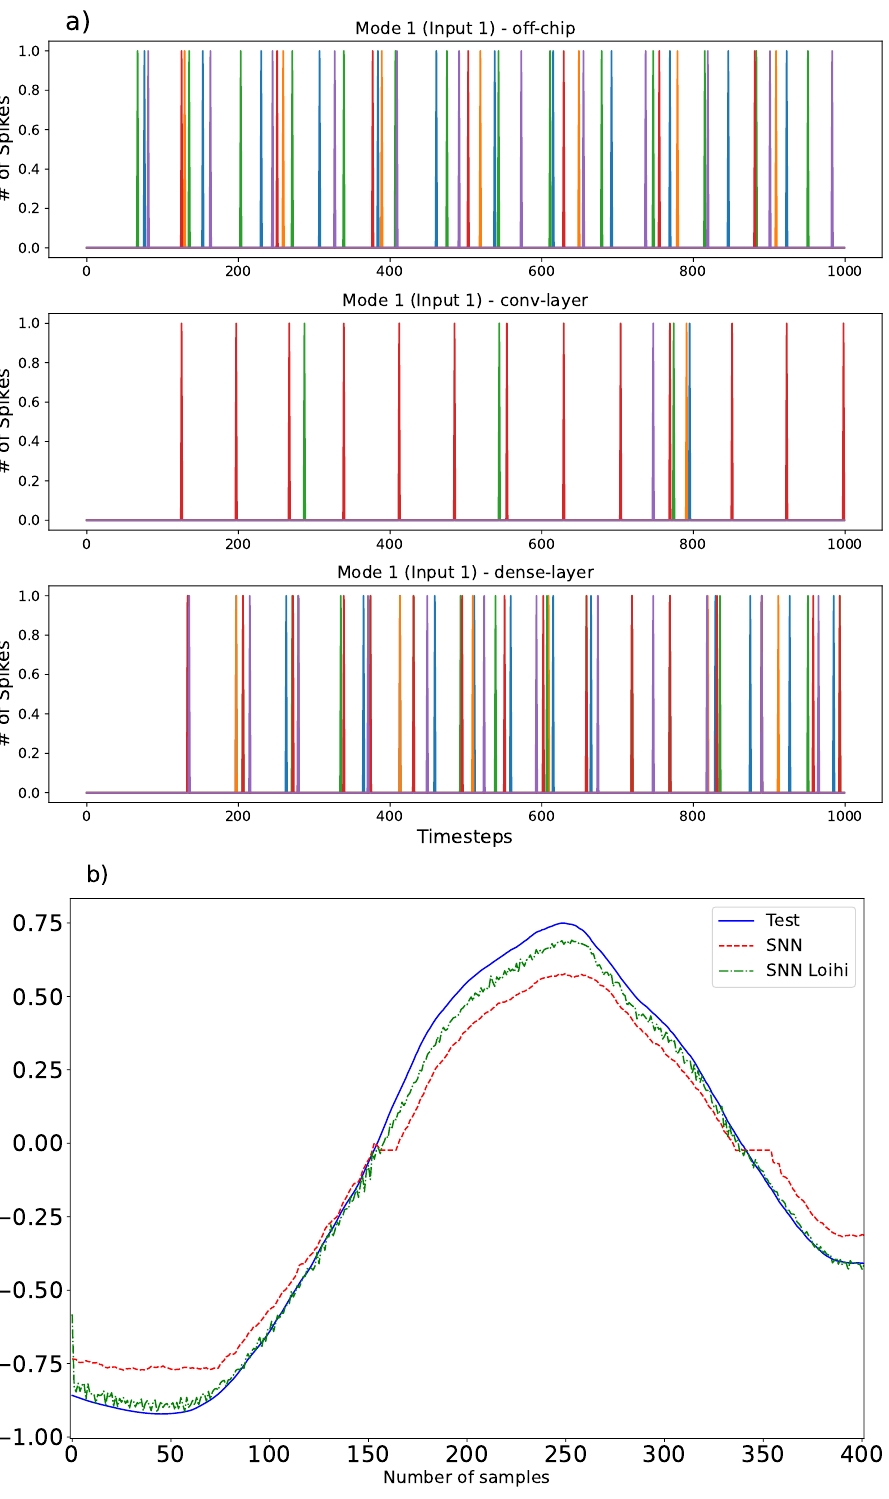
Figure 7. Results for mode 1: ( a ) Neural activities of 5 neurons of each layer. One input vector is shown over 1000 timesteps. ( b ) Predictions over the testing set with the SNN architecture (dashed red line) and running the SNN on the Loihi emulator (dash-dot green